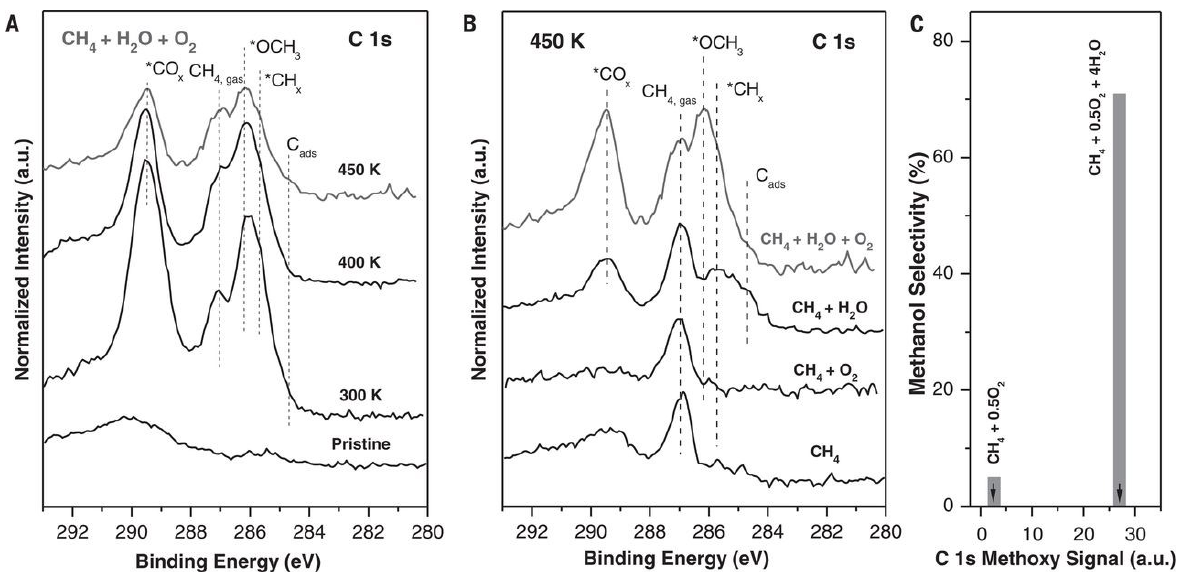
Figure 11. The AP-XPS spectra of C 1s region for ( A ) the CeO 2 /Cu 2 O/Cu(111) surface under a gas mixture of CH 4 , H 2 O and O 2 ; and ( B ) exposing CeO 2 /Cu 2 O/Cu(111) catalyst to different gas reactants at 450 K. ( C ) CH 3 OH selectivity generated with and without water. Reproduced with permission from ref [65]. Copyright 2020, American Association for the Advancement of Science.